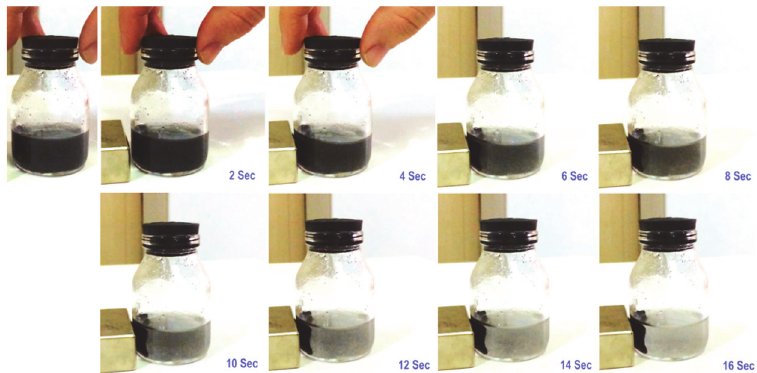
Figure 6: Rapid separation of magnetic nanocomposite from solution phase.